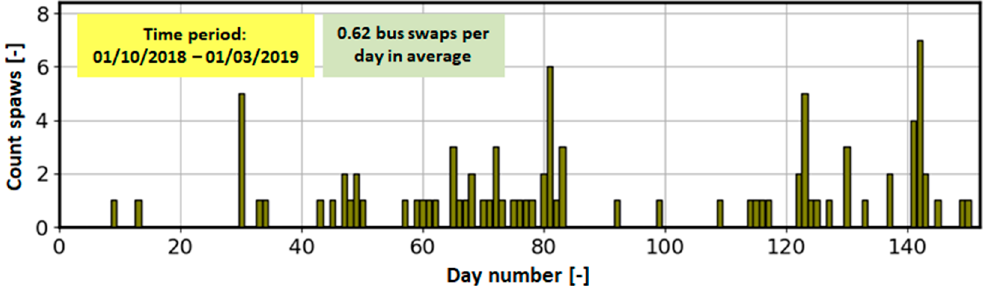
Figure 16. Number of daily bus swaps with reserve buses for BEV 2 case.